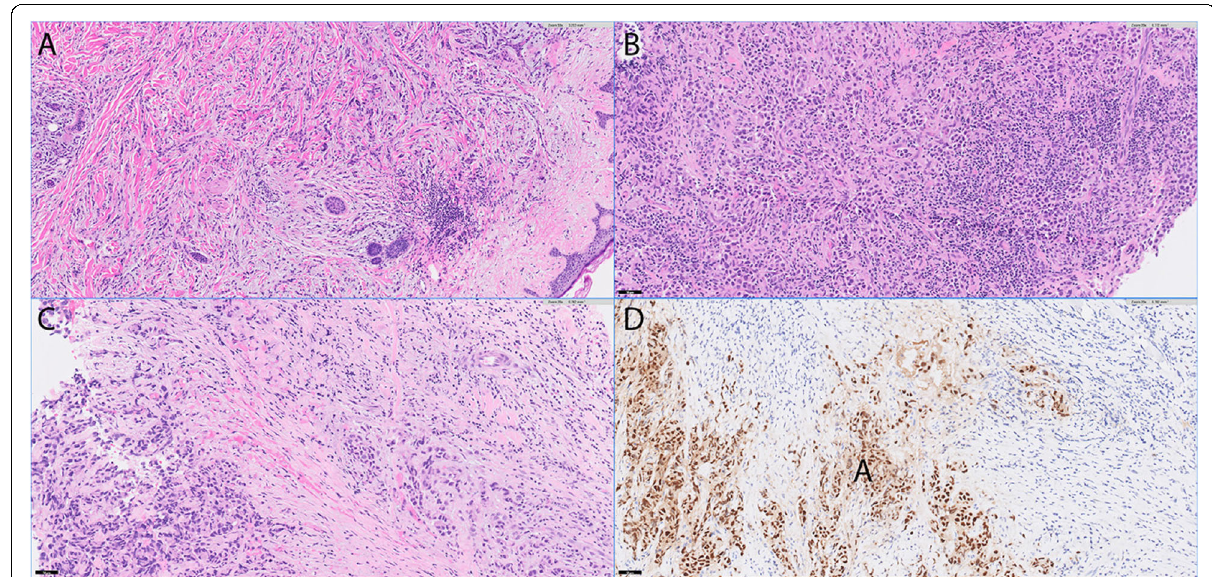
Fig. 2 Three cases with high tumor mutation burden. a - c Representative H&E images from three cases (#1 – 3) with high tumor mutation burden. d Estrogen receptor IHC staining from case #1.